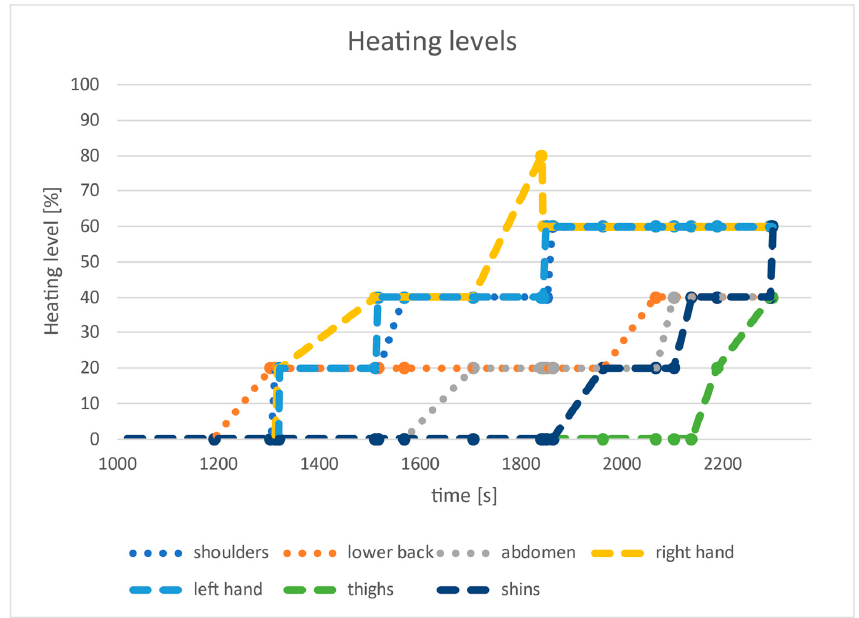
Figure 7. Heating levels for participant B when adjusting to reach subjective thermal comfort.